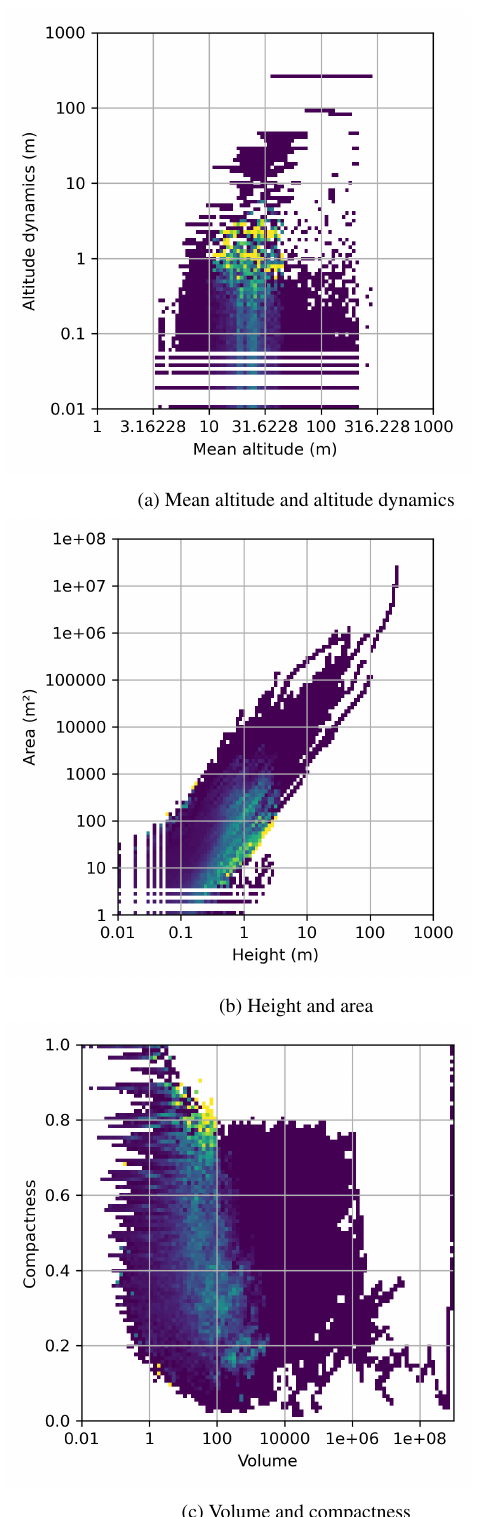
Figure 4. Activation maps of pattern spectra over the gold panning areas with the max-tree. The bin color represents the percentage of nodes defined as gold panning in the global spectrum. Values range from 0% (purple) to 100% (yellow). The more consistent the spectrum, the better the characterization.